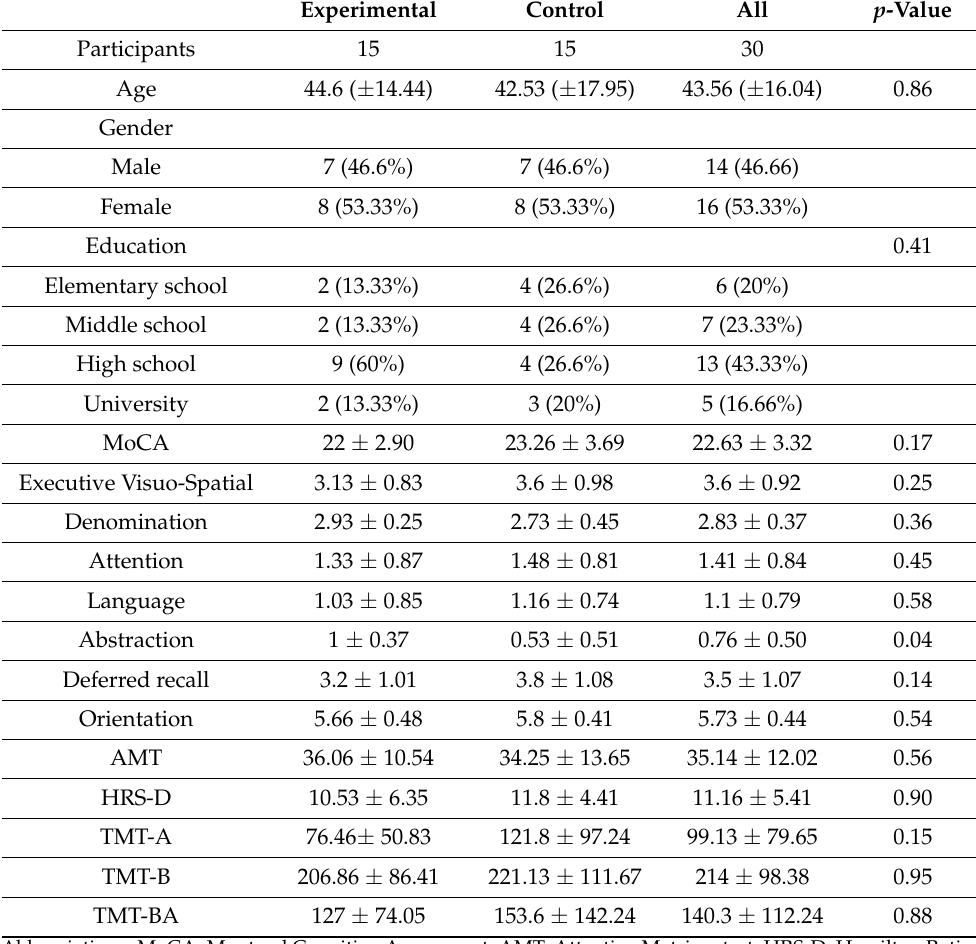
Table 1. Demographic and clinical description of the sample at the beginning of the study. Experimental Control All p -Value